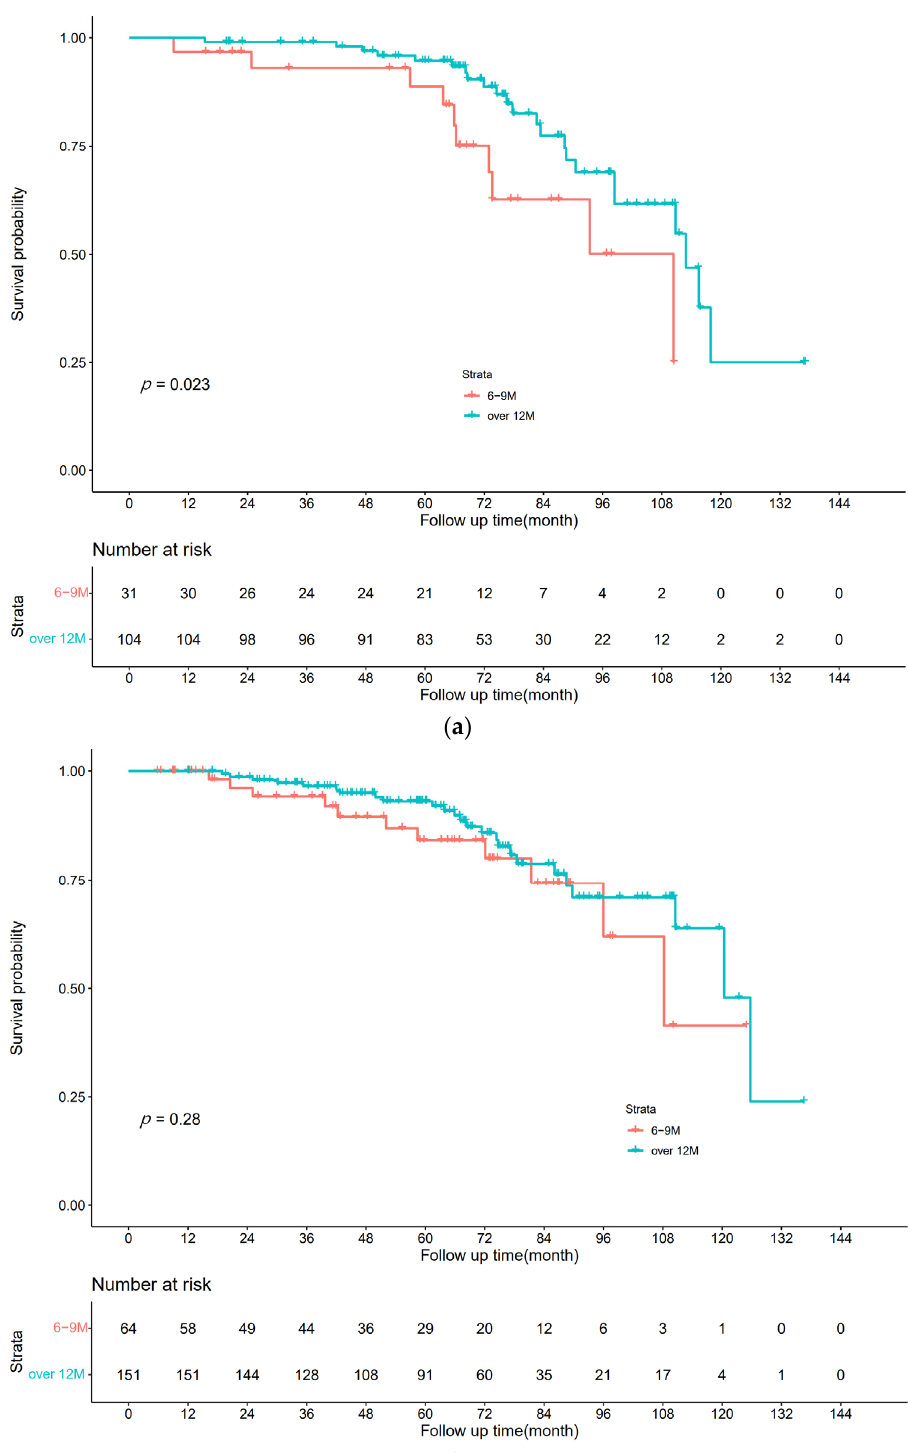
Figure 2. OS. ( a ) Stage III CRC; ( b ) high-risk stage II CRC.